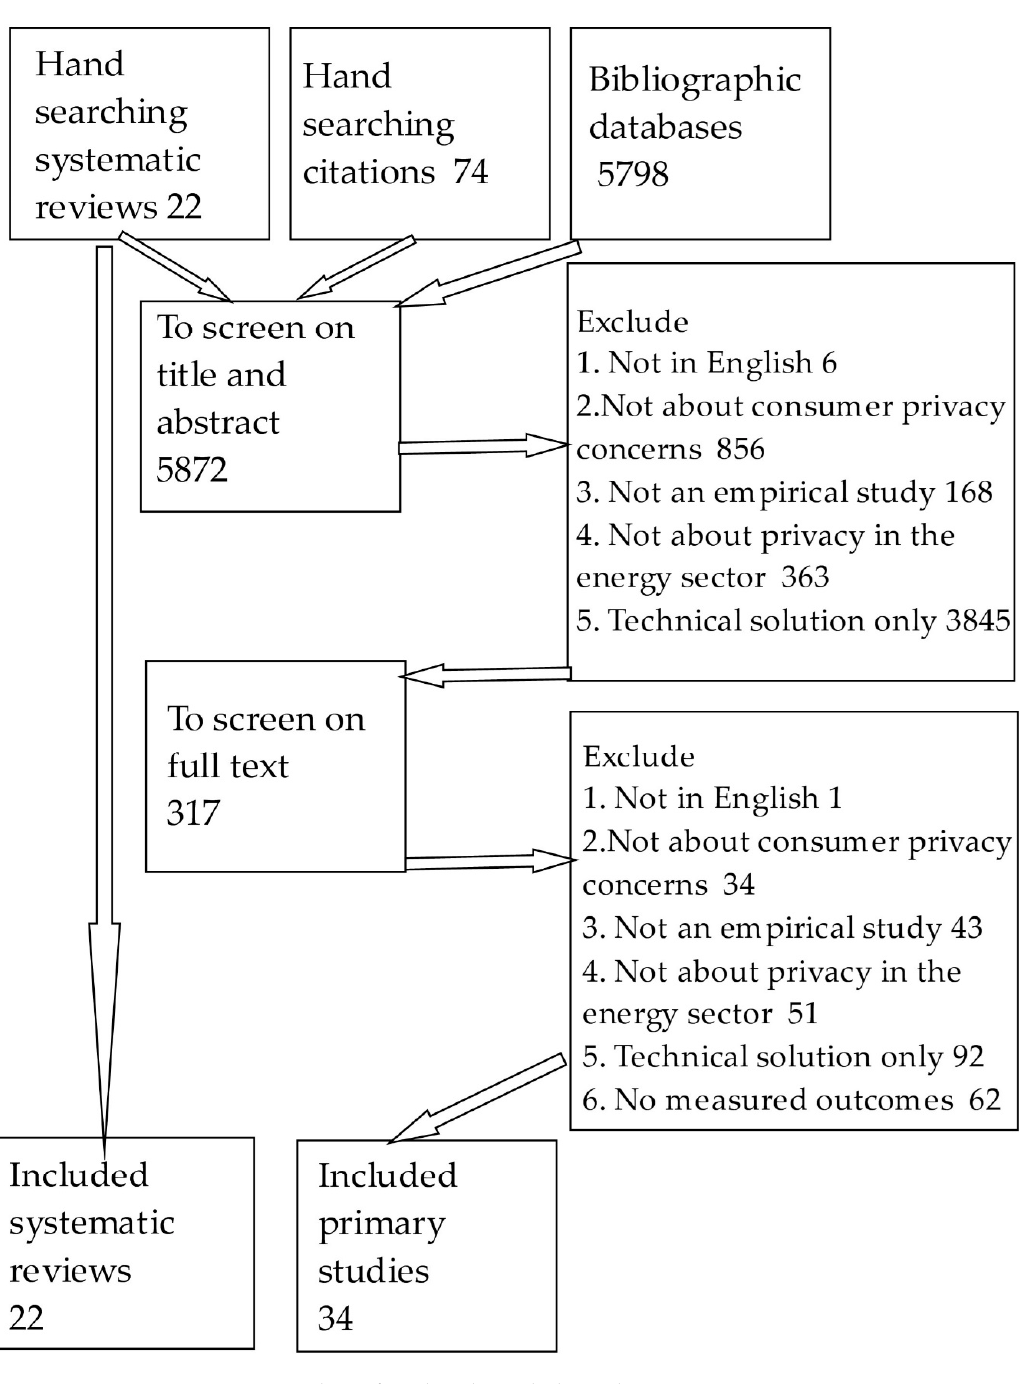
Figure 2. Flow of studies through the realist review process.